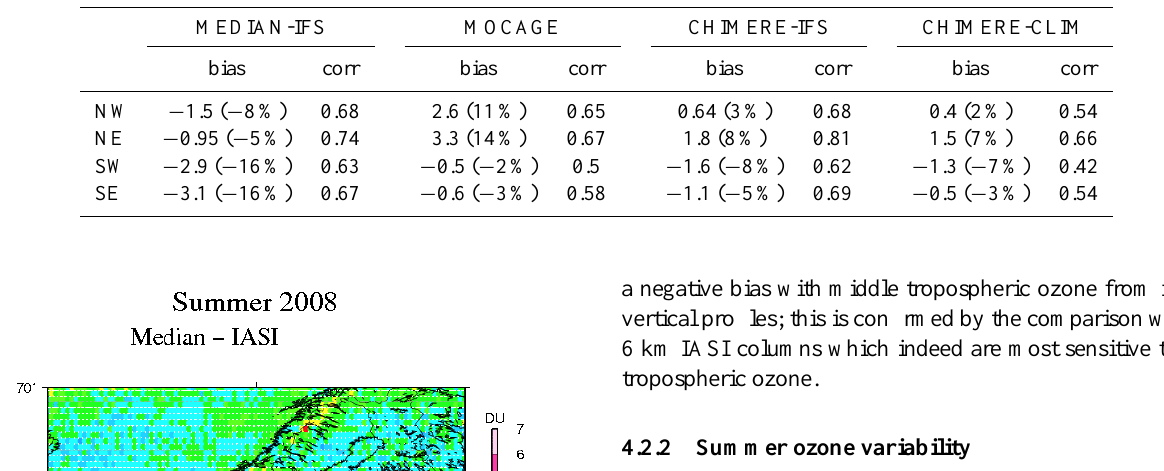
Table 4. The domain has been divided in 4 quadrants NW (North-West), NE (North-East), SW (South-West) and SE (South-East). The temporal evolution of 0-6km ozone partial columns from IASI and models are compared (for each quarter) in terms of their relative bias and Pearson’s correlation. MEDIAN-IFS stand for the median of models using IFS-MOZART as boundary condition. CHIMERE-IFS is one of these models and is compared with CHIMERE-CLIM that is using the monthly mean of the IFS-MOZART hourly values as BC. Biases are express in DU.